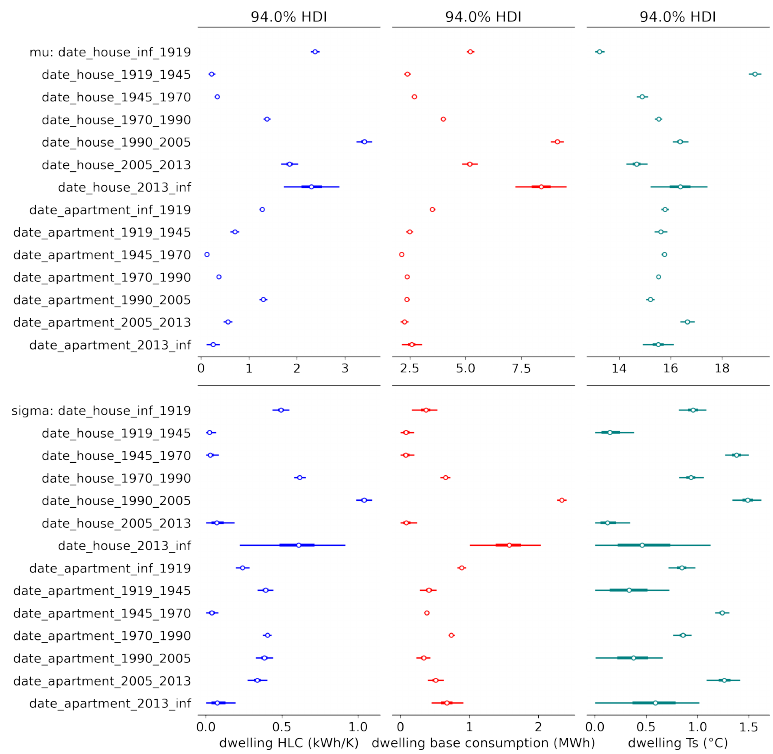
Figure 15. Inference results for types and dates